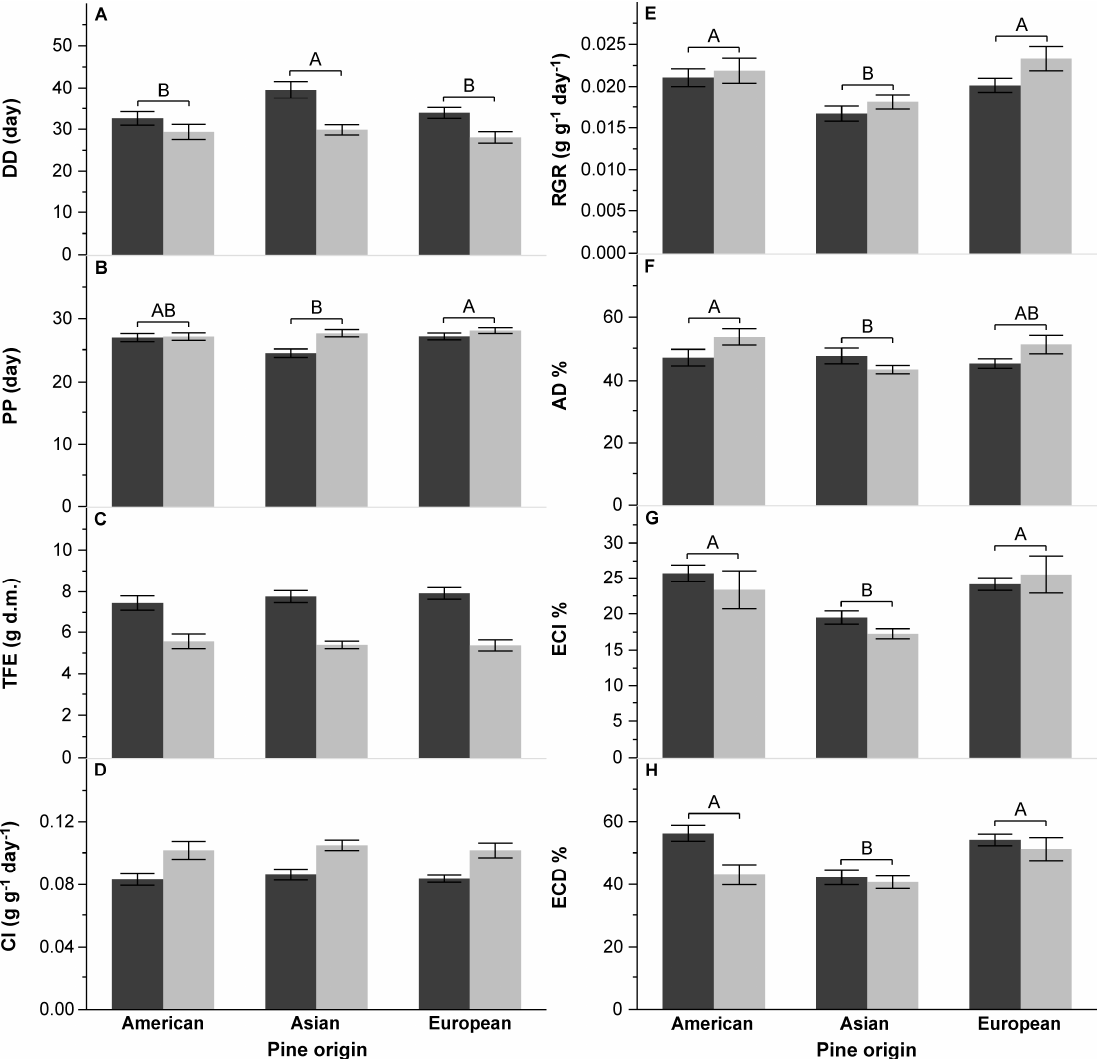
Figure 5. Mean values (±SE) of duration of development (DD; ( A )), pupal period (PP; ( B )), total food eaten (TFE; ( C )), consumption index (CI; ( D )), relative growth rate (RGR; ( E )), approximate digestibility (AD; ( F )), efficiency of conversion of ingested food (ECI; ( G )), and efficiency with which digested food was converted to body substance (ECD; ( H )) achieved by the pine-tree lappet ( Dendrolimus pini L.) larvae, which were fed with the needles of pines of different geographical origin (American, Asian, and European) classified by sex: females (dark) and males (light). Lowercase letters above the bars indicate result of Tukey’s post hoc test ( α = 0.05) for interaction pine origin × sex, and uppercase letters indicate result for pine origin treatment (see also Table 1). Levels not connected by same letter are significantly different.